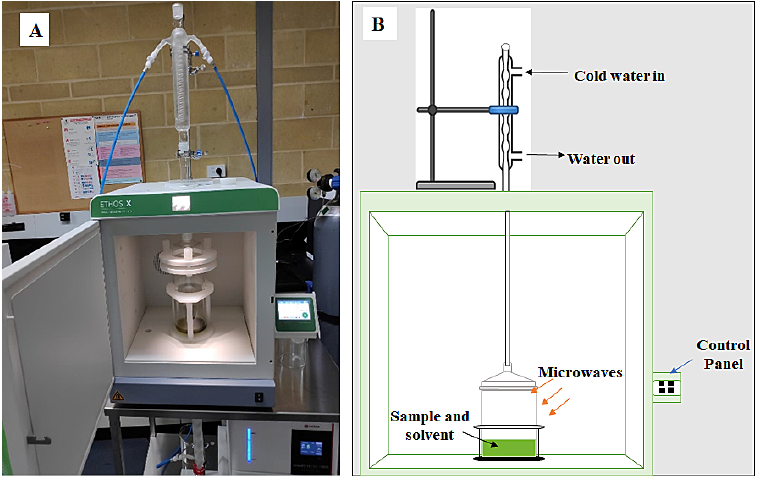
Figure 1. ETHOS X advanced microwave-assisted extraction system ( A ), experimental process, and scheme of the MAE system applied in this study ( B ).